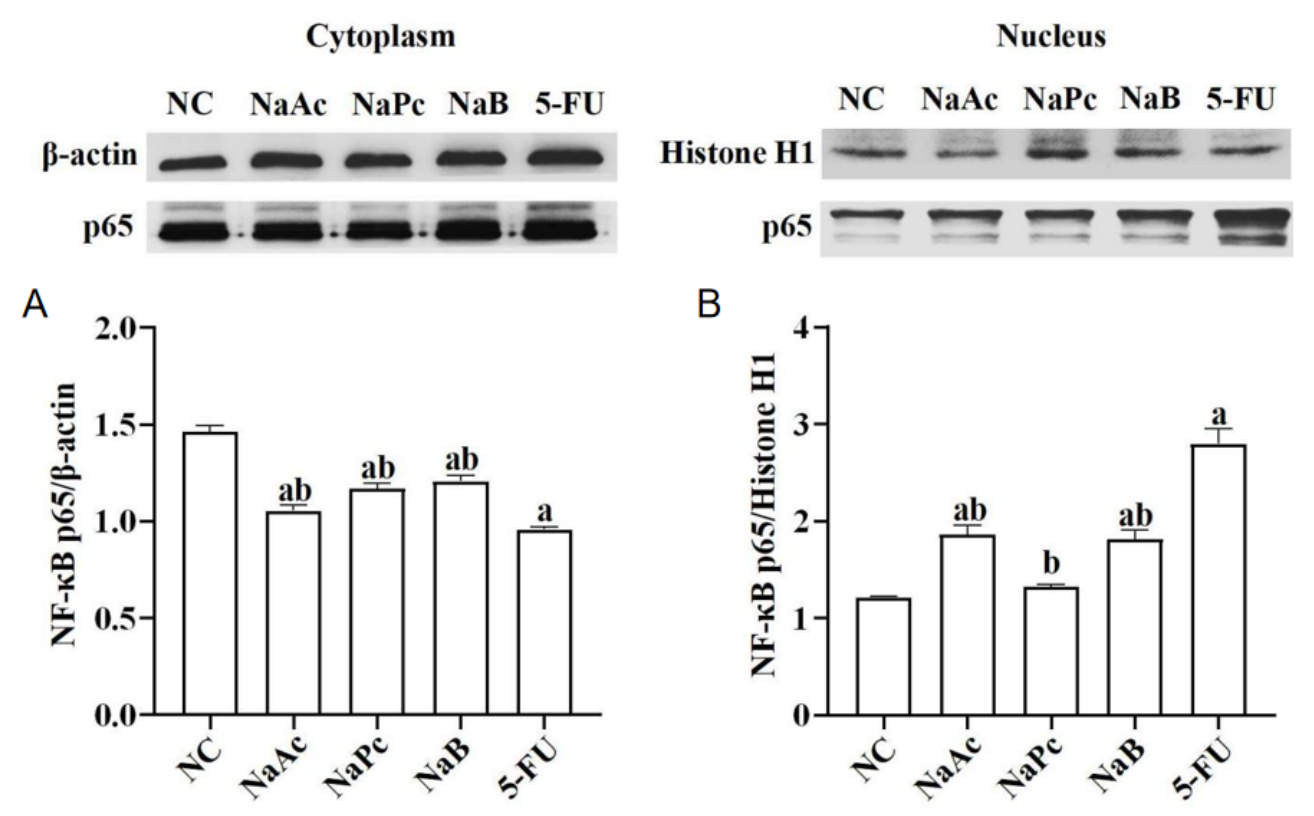
Figure 2. Effects of the SCFAs on NF − κ B p65 expression ( n = 3/group). The cells were pretreated with 100 µ mol/L of SCFAs (NaAc, NaPc, and NaB) and then stimulated with 5-FU (2.5 mmol/L). The expression of NF − κ B p65 in cell nuclear ( A ) and cytoplasmic ( B ) lysates were determined by Western blotting. Each experiment was repeated at least three times. Data are expressed as the mean ± SEM. a— p < 0.05, vs. the NC group; b— p < 0.05, vs. the 5-FU group.